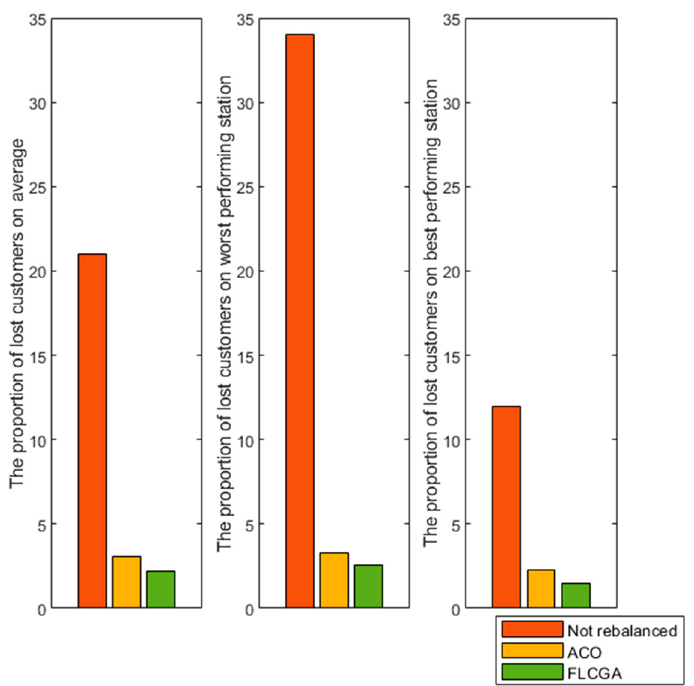
Figure 19. Performance comparison: the proportion of lost customers (%).